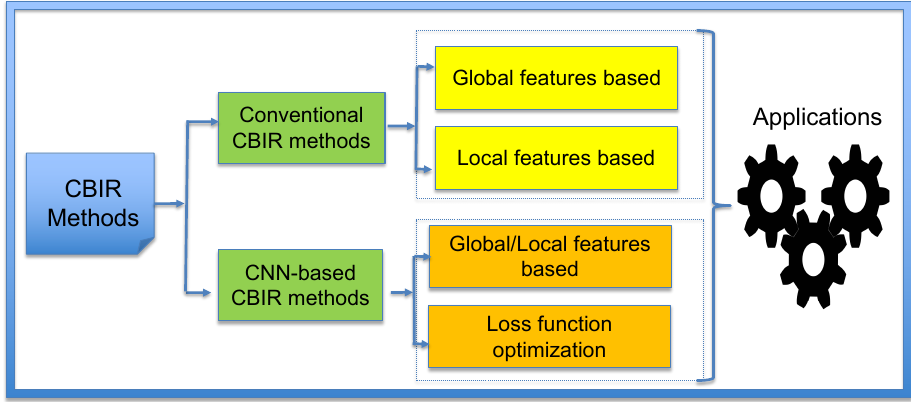
Figure 2. Classification of content-based image retrieval